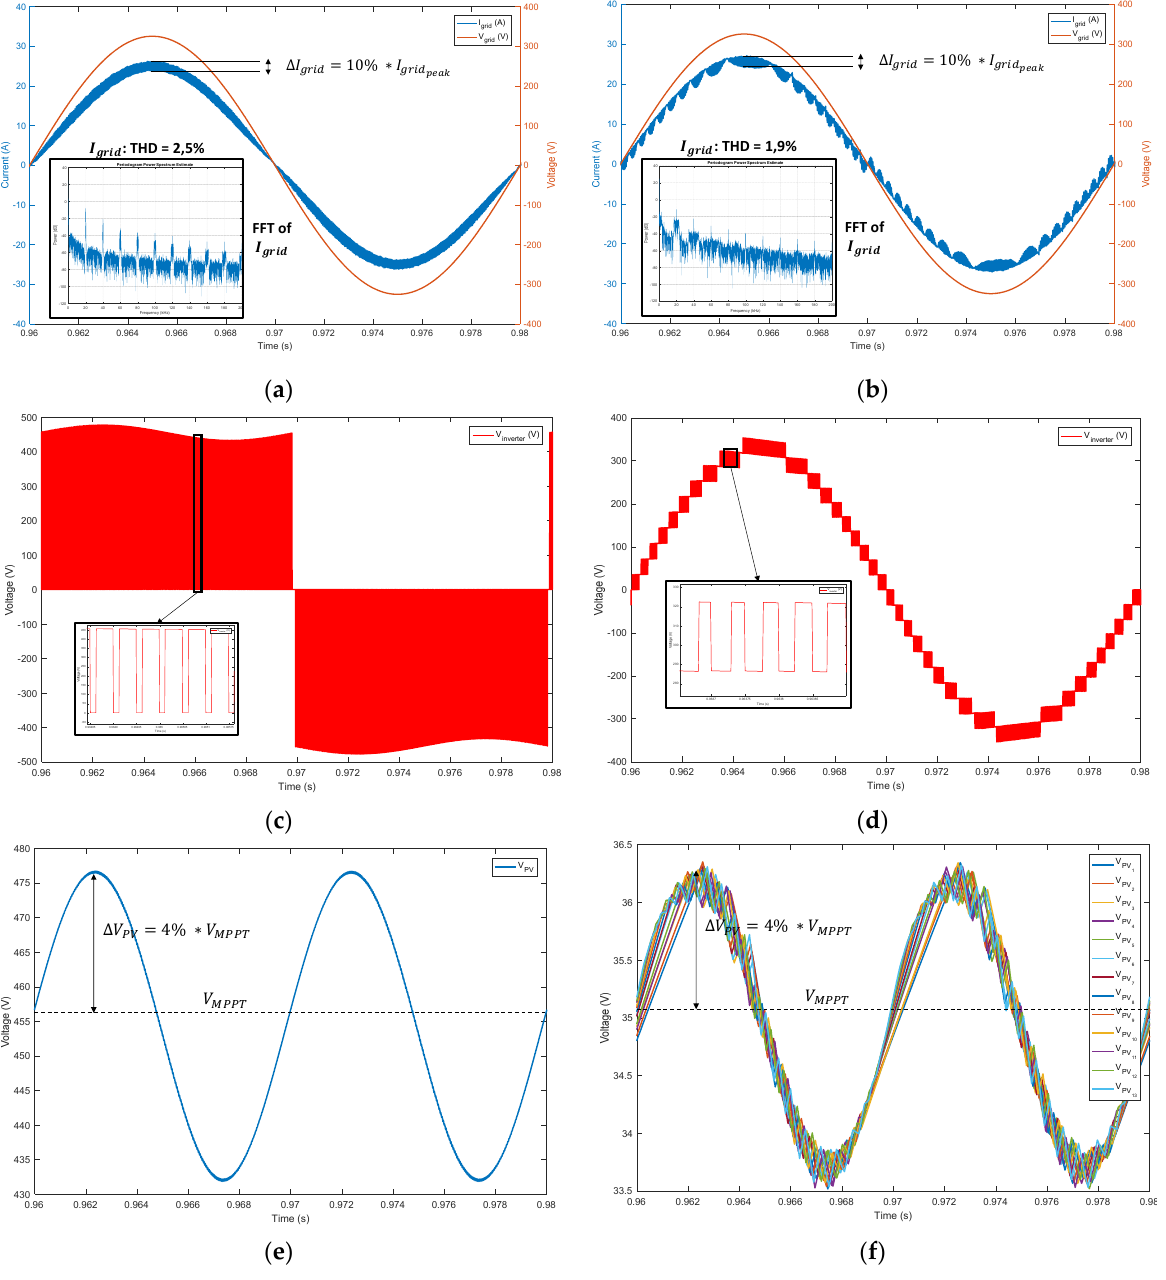
Figure 6. ( a ) Grid Voltage (red) and Grid Current (blue) for the CHB ( b ) Grid Voltage (red) and Grid Current (blue) for the CHBMLI ( c ) Inverter Voltage (red) for the CHB ( d ) Inverter Voltage (red) for the CHBMLI ( e ) PV Voltage for the CHB (blue) ( f ) PV Voltages for the CHBMLI. The Conventional H-Bridge (CHB) and the CHBMLI both have a maximum output current ripple ∆ I grid limited to 10% of the peak output current I grid (Figure 6a,b), which peak validate the design of both inductors. Furthermore, for both simulations, the current (blue) is set in phase with the grid voltage (red). The THD of the CHBMLI (1.9%) is slightly lower than the THD of the CHB (2.5%). This is due to the control algorithm that mitigates some harmonics. However, the THD of the CHBMLI could be further improved by using Selective Harmonics Elimination [21]. The output waveform of both inverters is presented in Figure 6c for the CHB and Figure 6d for the CHBMLI. The CHB has a three-level output voltage with high switching voltages ( ∼ 450 V), and the CHBMLI has a stair-shaped